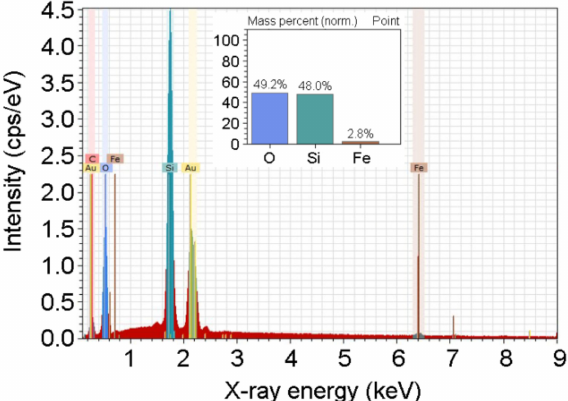
Figure 3. EDS analysis of the Fe + -functionalized silica microspheres.